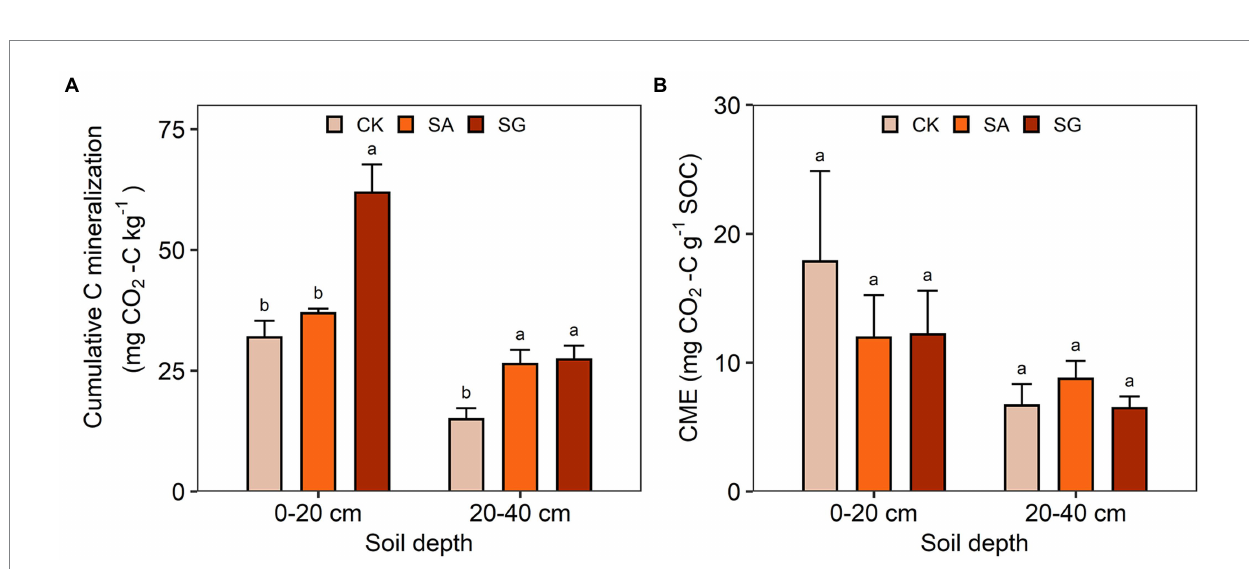
FIGURE 7 Effects of ecological restoration on (A) the cumulative carbon mineralization and (B) carbon mineralization efficiency (CME). Error bars indicate standard deviation; different lowercase letters indicate significant differences at p < 0.05 among treatments, based on the Tukey’s honest significance difference (HSD)